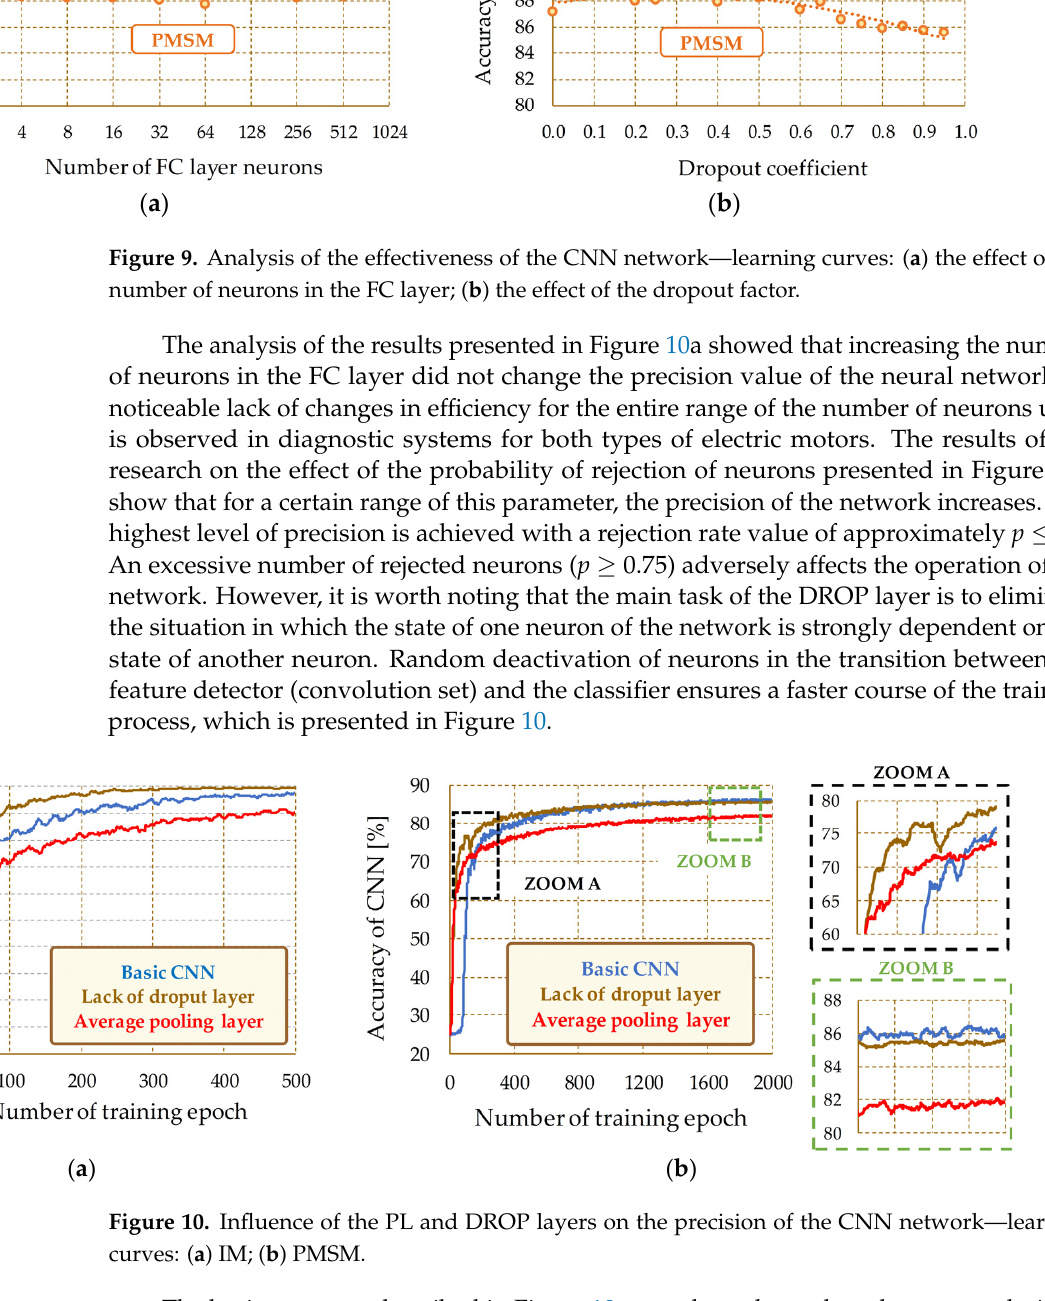
( b ) Figure 11. Influence of the CNN activation function on the precision of the diagnostic system— learning curves: ( a ) induction motor; ( b ) PMSM. As shown in Figure 11, the activation function used does not significantly affect the course of the neural network training process. The effectiveness of diagnostic systems is similar for all cases analyzed, which is additionally confirmed by the list in Table 4. How- ever, the use of the activation function in the form of a hyperbolic tangent is characterized by greater dynamics of the learning process. It should be noted, however, that the applica- tion of this function is more complex in terms of computation; therefore, the update of the weighting factors is slower than when using the ReLU function or its variants.